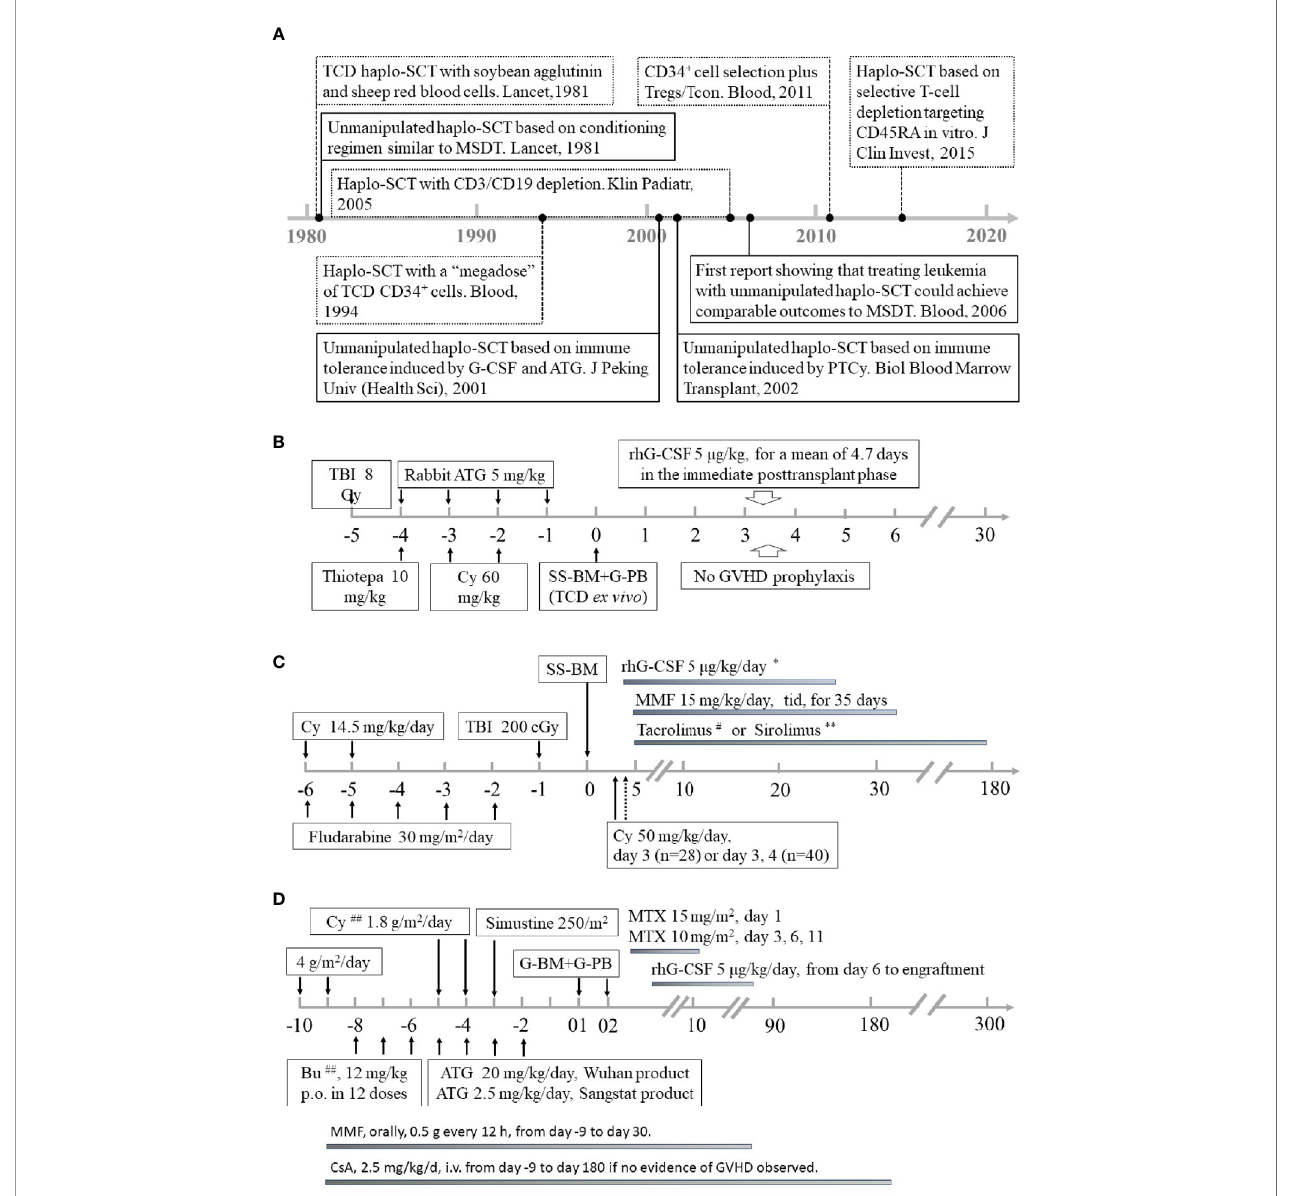
FIGURE 1 | Summary of historical perspective and conditioning regimens of different haploidentical stem cell transplantation modalities for AML. (A) The historical perspective of haplo-SCT for AML. (B) University of Perugia: myeloablative conditioning and ex vivo TCD with “ megadose ” CD34 + cell allografts. (C) Peking University: myeloablative conditioning based on immune tolerance induced by G-CSF and ATG. (D) Johns Hopkins University: nonmyeloablative conditioning with high-dose PT/Cy. Panels (B – D) were adapted from Aversa et al. (Blood, 1994), Luznik et al. and Cieri et al. (Biol Blood Marrow Transplant,2008; Biol Blood Marrow Transplant,2015), and Huang et al. (Bone Marrow Transplant,2006), respectively. AML, acute myeloid leukemia; Haplo-SCT, haploidentical stem cell transplantation; Tregs, regulatory T cells; Tcon, conventional T cells; MSDT, human leukocyte antigen (HLA)-matched sibling donor transplantation; G-CSF, granulocyte colony- stimulating factor; ATG, anti-thymocyte globulin; PTCy, posttransplantation cyclophosphamide; TBI, Total body irradiation; SS-BM, steady-state bone marrow; G-PB, G-CSF mobilized peripheral stem cells; GVHD, graft-versus-host disease; MMF, mycophenolate mofetil; G-BM, G-CSF-stimulated bone marrow harvests; MTX, Methotrexate; Bu, Busulfan; CSA, Cyclosporin A *Subcutaneous injection starting on Day 4 and continuing until recovery of neutrophils to >1000/ m l for 3 days. # Tacrolimus was initiated at a dose of 1 mg i.v. daily, adjusted to achieve a therapeutic level of 5 – 15 ng/mL, and then converted to oral form until discontinuation. If there was no active GVHD, tacrolimus was tapered off by Day 180. **Sirolimus (orally, monitored 2 times each week to maintain a target therapeutic plasma level of 8 to 14 ng/mL during the fi rst 2 months after transplantation, thereafter of 5 to 8 ng/mL until discontinuation). ## Patients 50 years old or older were conditioned with the same regimen as in (D) , except for lower dosages of Bu (6 – 8 mg/kg) and Cy (1.0 g/m 2